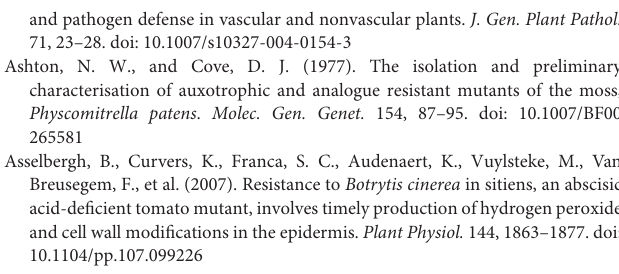
FIGURE S1 | Three-dimensional model of PpPR-10. The model was built using the I-TASSER server. From five PpPR-10 models predicted, the best model is shown with a confidence score ( C -score) of 0.49. FIGURE S2 | Phylogenetic analysis of deduced PR-10 proteins in P. patens and other plants. Full-length amino acid sequences were aligned using ClustalW algorithm and a phylogenetic tree was constructed by the neighbor-joining method using MEGA version 5.05. Numbers at branch nodes represent the confidence level of 1000 bootstrap replications. The identities of the protein sequences are indicated by their locus name according to Phytozome. The P. patens PR-10 proteins containing two Bet v1 domains are highlighted with a red spot. The abbreviations of species are as follows: Sm, Selaginella moellendorffii ; Gm, Glycine max ; Egr, Eucalyptus grandis; Stu, Solanum tuberosum ; Aco, Aquilegia coerulea Goldsmith ; Vvi, Vitis vinifera . FIGURE S3 | Expression profiles of P. patens PR-10 genes during development and B. cinerea inoculation. Transcript levels of P. patens PR-10 genes are presented as heat maps generated at Genevestigator based on microarray data. Values are expressed in percent of potential expression (A) and log-scale of potential expression (B) of each gene. FIGURE S4 | Reactive oxygen species (ROS) accumulation in wild type and PpPR-10 overexpressing plants inoculated with P. irregulare . DAB and NBT staining of control and P. irregulare -inoculated moss colonies performed after 24 h. Representative colonies are shown. Scale bars represent 0.5